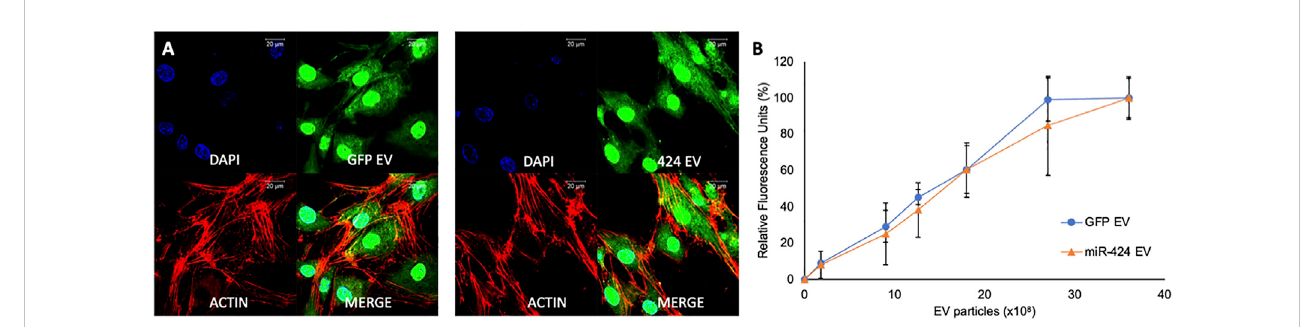
FIGURE 2 EndocytosisofEVsbyMSCs. (A) Representativeconfocalmicrographsof fl uorescentlylabeled(green)controland424 EVsendocytosedbyHMSCs.Red represents actin counter stain, and the nuclei are stained blue with DAPI. Scale bar represents 20 μ m. (B) Dose-dependent endocytosis of fl uorescently labeled control and 424 EVs by HMSCs. No signi fi cant difference was observed between the ability of the two EVs to be endocytosed by HMSCs. Data are represented as mean ( ± SD).